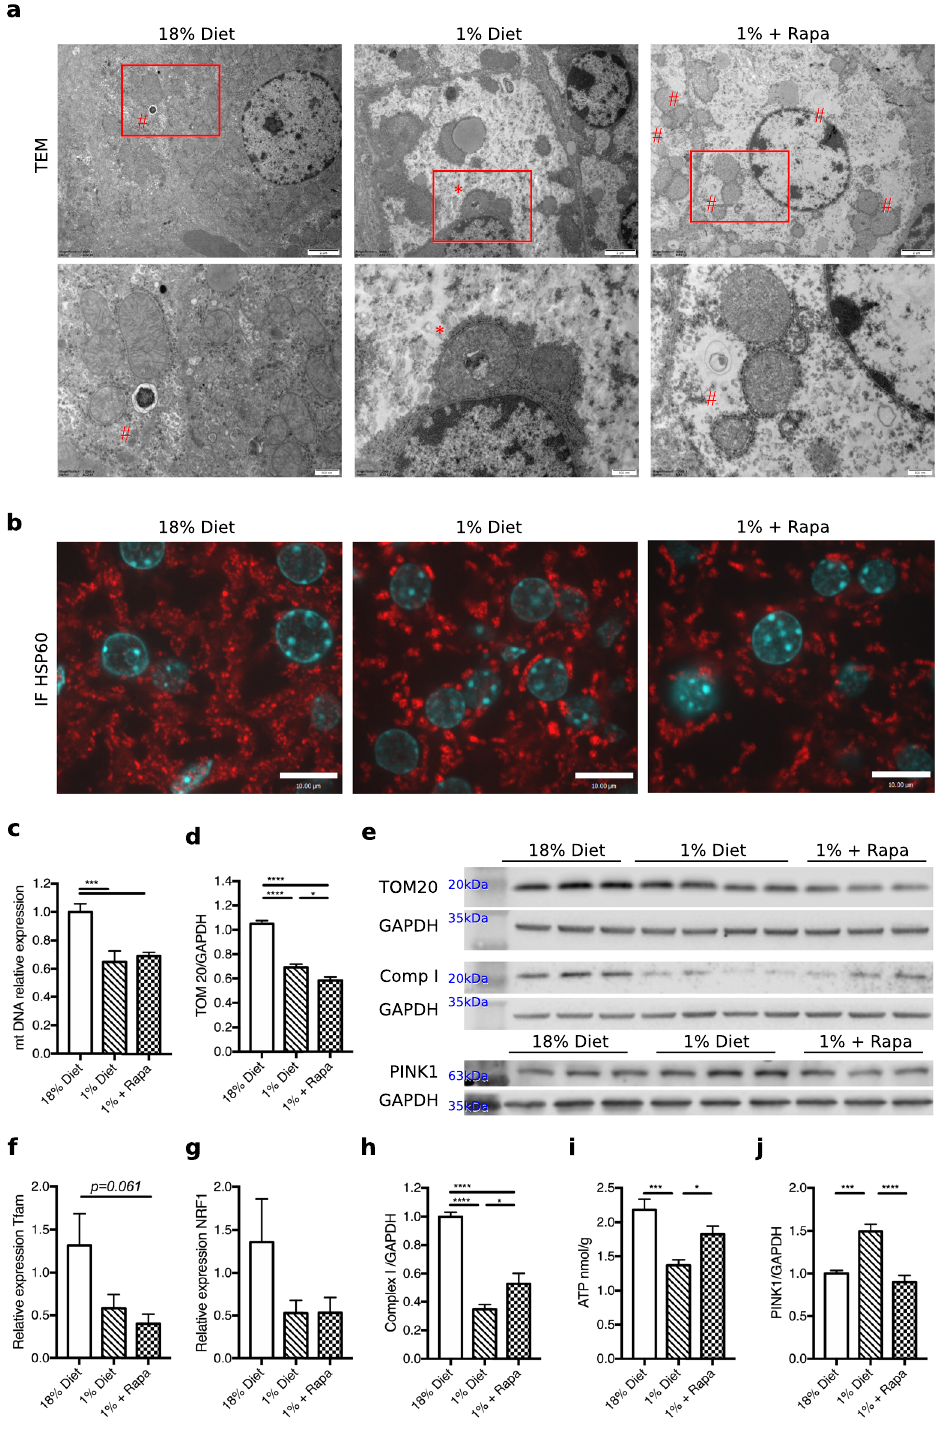
Figure 3. Low protein fed mice illustrate changed mitochondrial morphology and markers of function which were mitigated by rapamycin. ( a ) TEM magnification × 4000, scale bar 2um, red square encircles a mitochondria with an inclusion body, # indicate autophagosomes. ( b ) HSP60 IF staining in red, scale bar 10um. ( c ) mitochondrial DNA. ( d ) TOM20 quantification of western blot relative to 18% diet. ( e ) Westernblots. ( f ) Relative expression Tfam. ( g ) Relative expression NRF1. ( h ) Complex I quantification of western blot relative to 18% diet. ( i ) Hepatic ATP levels, nmol/g wet weight. ( j ) PINK1 quantification of western blot relative to 18% diet. The westerns were cut prior to incubation with the primary antibodies, the full size blots can be seen in Supplementary Fig. S7. * p < 0.05, ** p < 0.005, *** p < 0.0005, **** p <